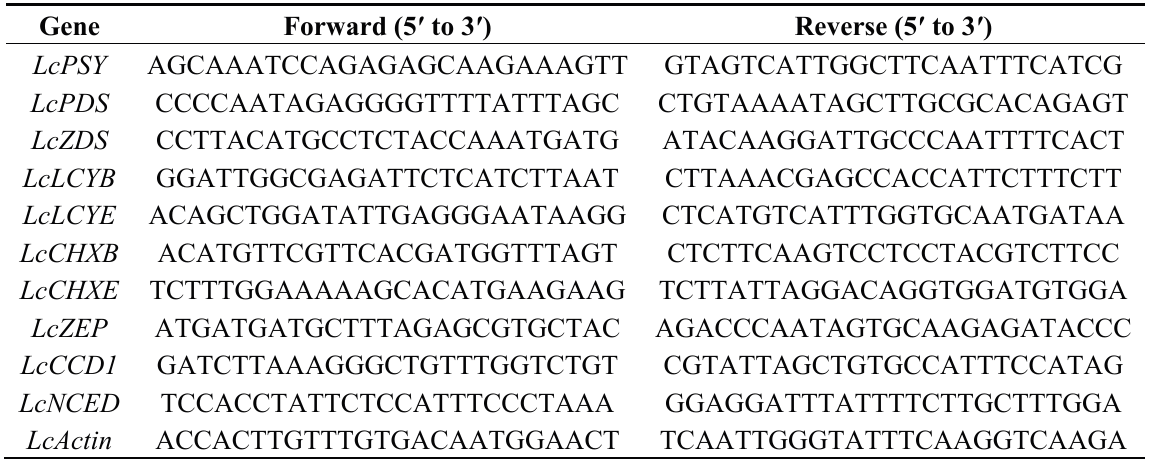
Table 3. Primers used for real-time